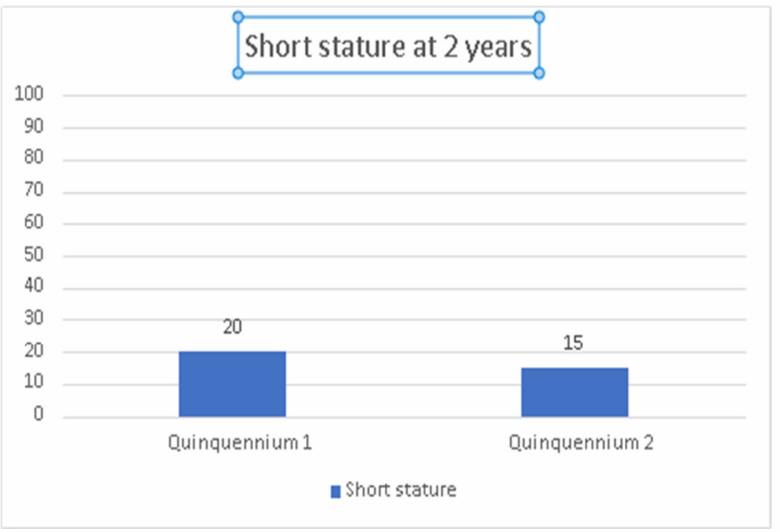
Figure 3. Prevalence of short stature ( − 2 SD) in very low birth weight infants (quinquennium 1: 2002–2006 vs. quinquennium 2: